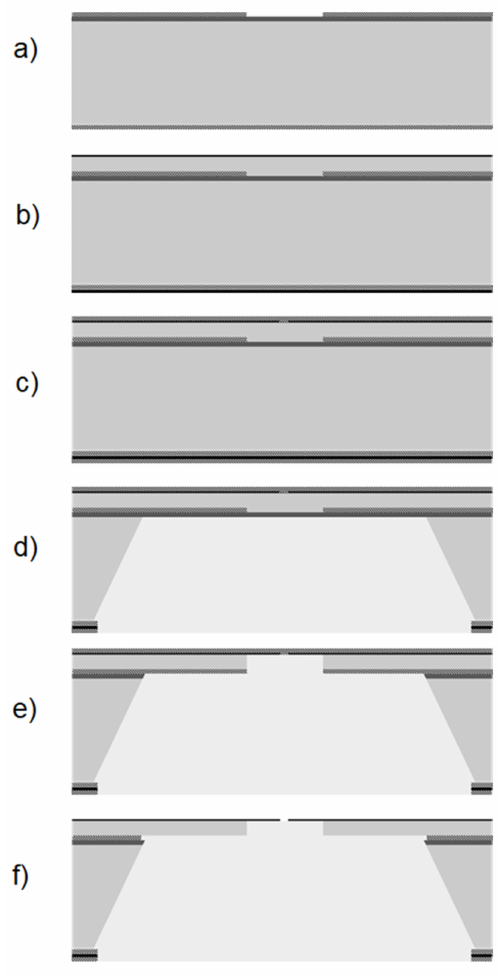
Figure 2. Membrane-in-membrane fabrication sequence schematic. Buried mask deposition and pattern ( a ), polysilicon and silicon-rich silicon nitride deposition ( b ), orifice patterning and silicon oxide deposition ( c ), backside mask pattern and anisotropic bulk etching ( d ), polysilicon etching from the wafer backside ( e ), and final orifice release by silicon oxide wet etching ( f ).